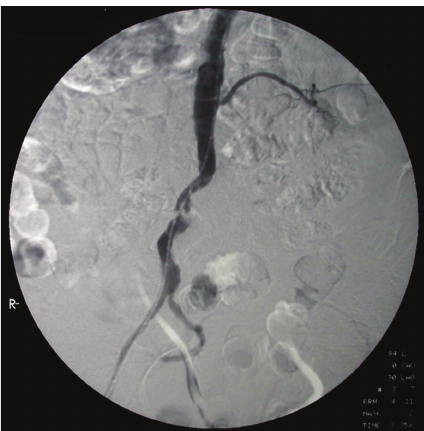
Figure 1: Patient’s preoperative intra-arterial subtraction angiogra- phy revealing TASC D aortoiliac